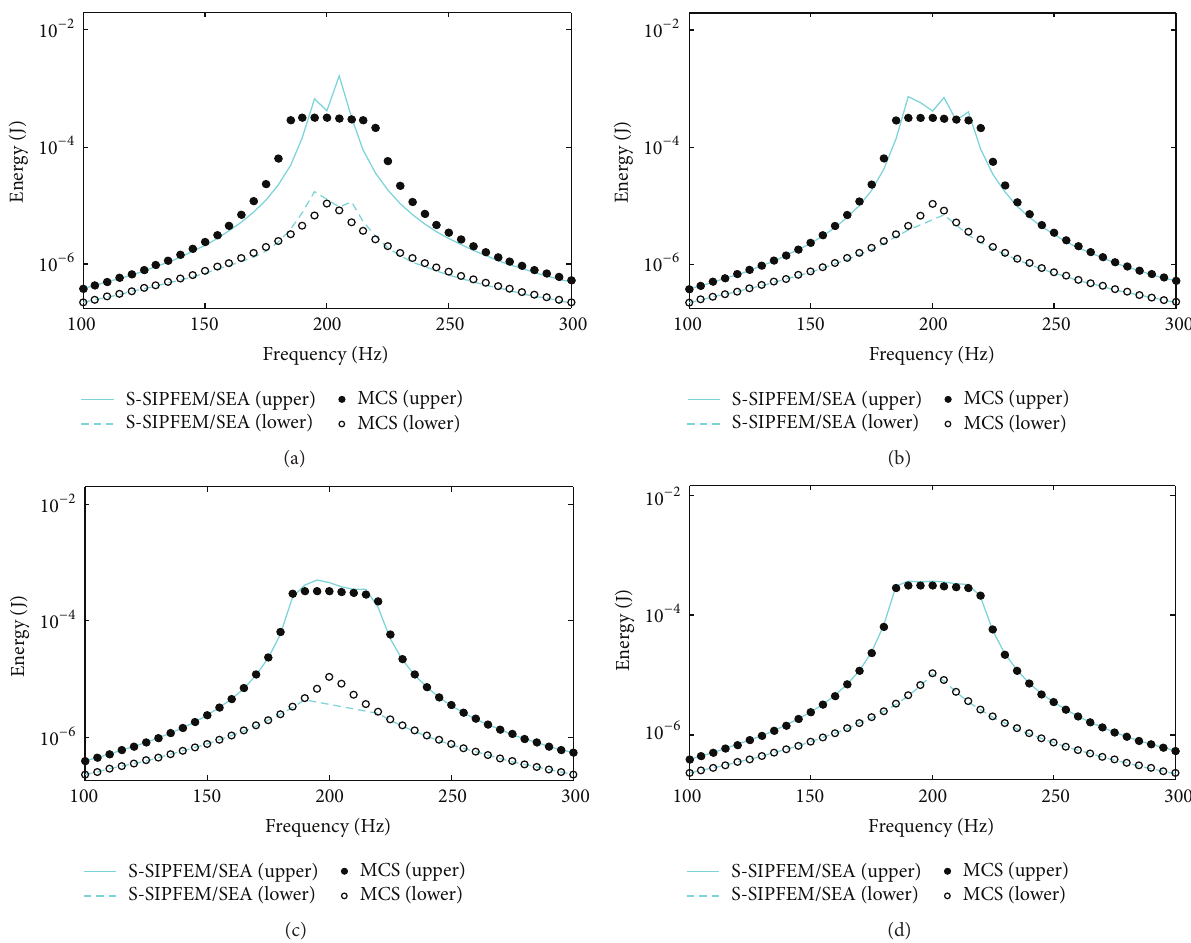
Figure 4: The bounds of the plate energy: (a) one subinterval, (b) two subintervals, (c) four subintervals, and (d) eight subintervals.